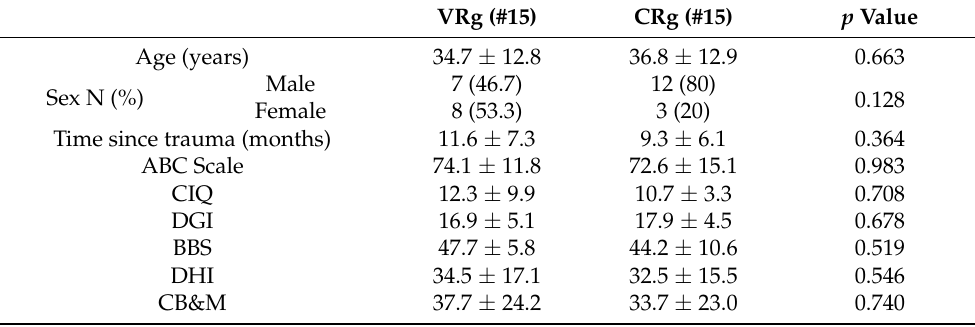
Table 1. Demographic and clinical characteristics at baseline (mean ± SD); VRg = vestibular reha- bilitation group; CRg = conventional rehabilitation group; ABC Scale =Activities-Specific Balance Confidence Scale ranging from 0 (no confidence) to 100 (complete confidence); BBS = Berg Balance Scale, ranging from 0 (lowest level of function) to 58 (highest level of function); CB&M = Community Balance and Mobility Scale ranging from 0 (complete inability to perform the tasks) to 96 (the most successful completion of the tasks possible); CIQ = Community Integration Questionnaire ranging from 0 to 29 (high scores represent greater independence and community integration); DGI = Dynamic Gait Index ranging from 0 (lowest level of function) to 24 (highest level of function); DHI = Dizziness Handicap Inventory, ranging from 0 to 100 (the higher the score, the greater the perceived handicap due to dizziness). Student’s t -tests and a chi-square test were used to test group similarity at baseline. VRg (#15) CRg (#15) p Value Age (years) 34.7 ± 12.8 36.8 ± 12.9